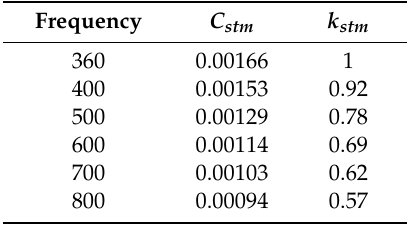
Table 2. Starting peak torque coe ffi